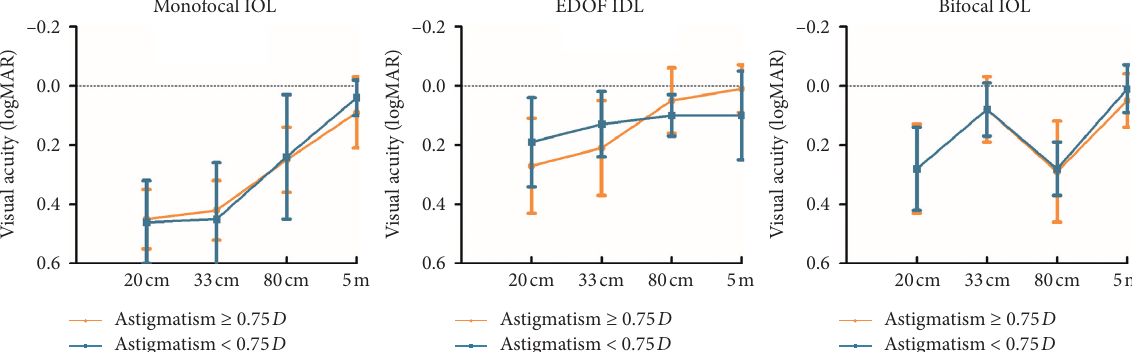
Figure 5: Comparison of the mean uncorrected visual acuity, from far to near, between the two astigmatism subgroups in the 3 intraocular lens (IOL) groups. No significant difference was observed between the two astigmatism subgroups in any of the 3 IOL groups. Error bars represent the standard deviation (SD) of the mean (logMAR � logarithm of minimum angle of curve, ranging from − 4.0 D (25 cm) to − 2.5 D (40 cm), with observed that the uncorrected near vision of the EDOF IOL the EDOF IOL than that with the bifocal IOL. However, we targeting slight myopia was similarly satisfactory as that of